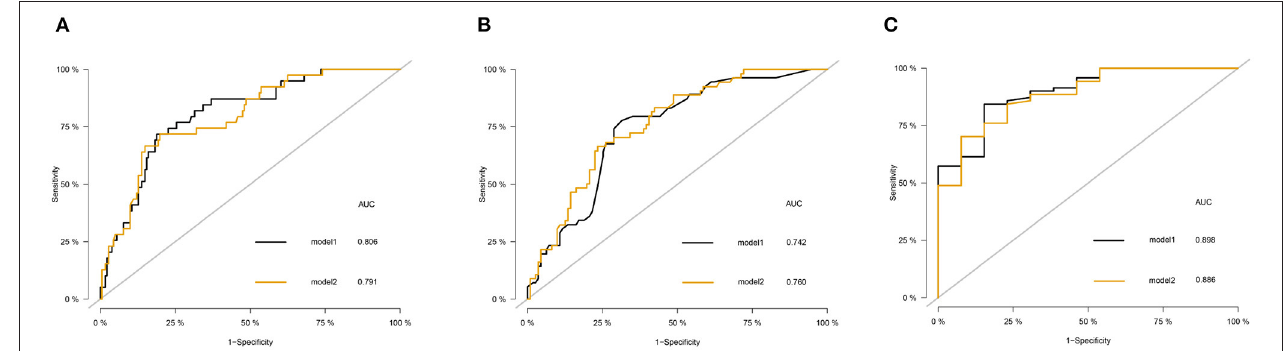
FIGURE 1 | The receiver operating characteristic (ROC) curve of the model 1 and model 2 in the training set. (A) Comparison of ROC curves of model 1 and model 2 for predicting the survival of patients with disorder of consciousness (DOC) at 16 months. (B) Comparison of ROC curves of model 1 and model 2 for predicting the survival of patients with DOC at 32 months. (C) Comparison of ROC curves of model 1 and model 2 for predicting the survival of patients with DOC at 48 months.